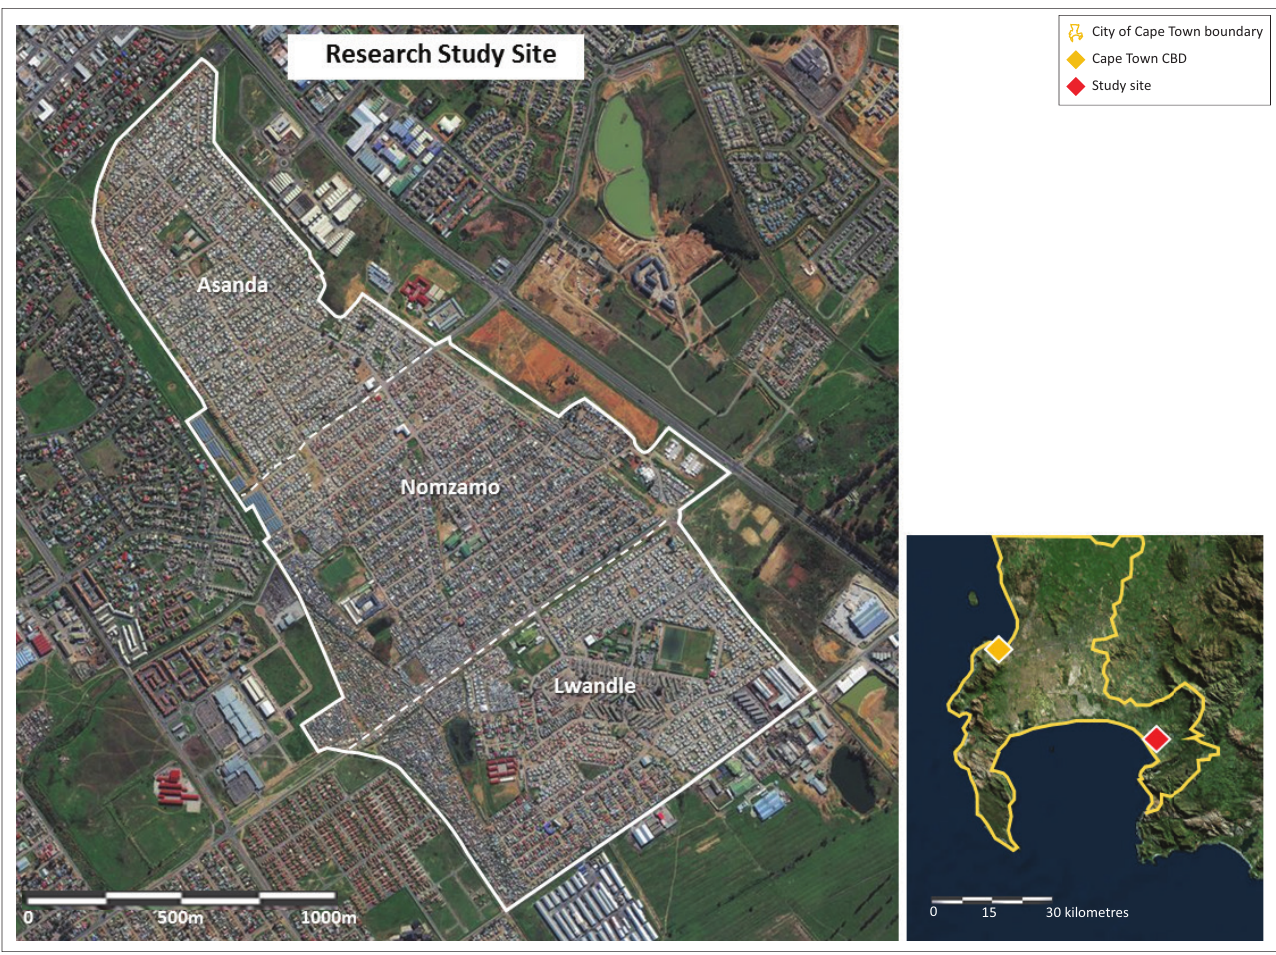
FIGURE 2: Map of the research study site; Nomzamo, Lwandle and Asanda